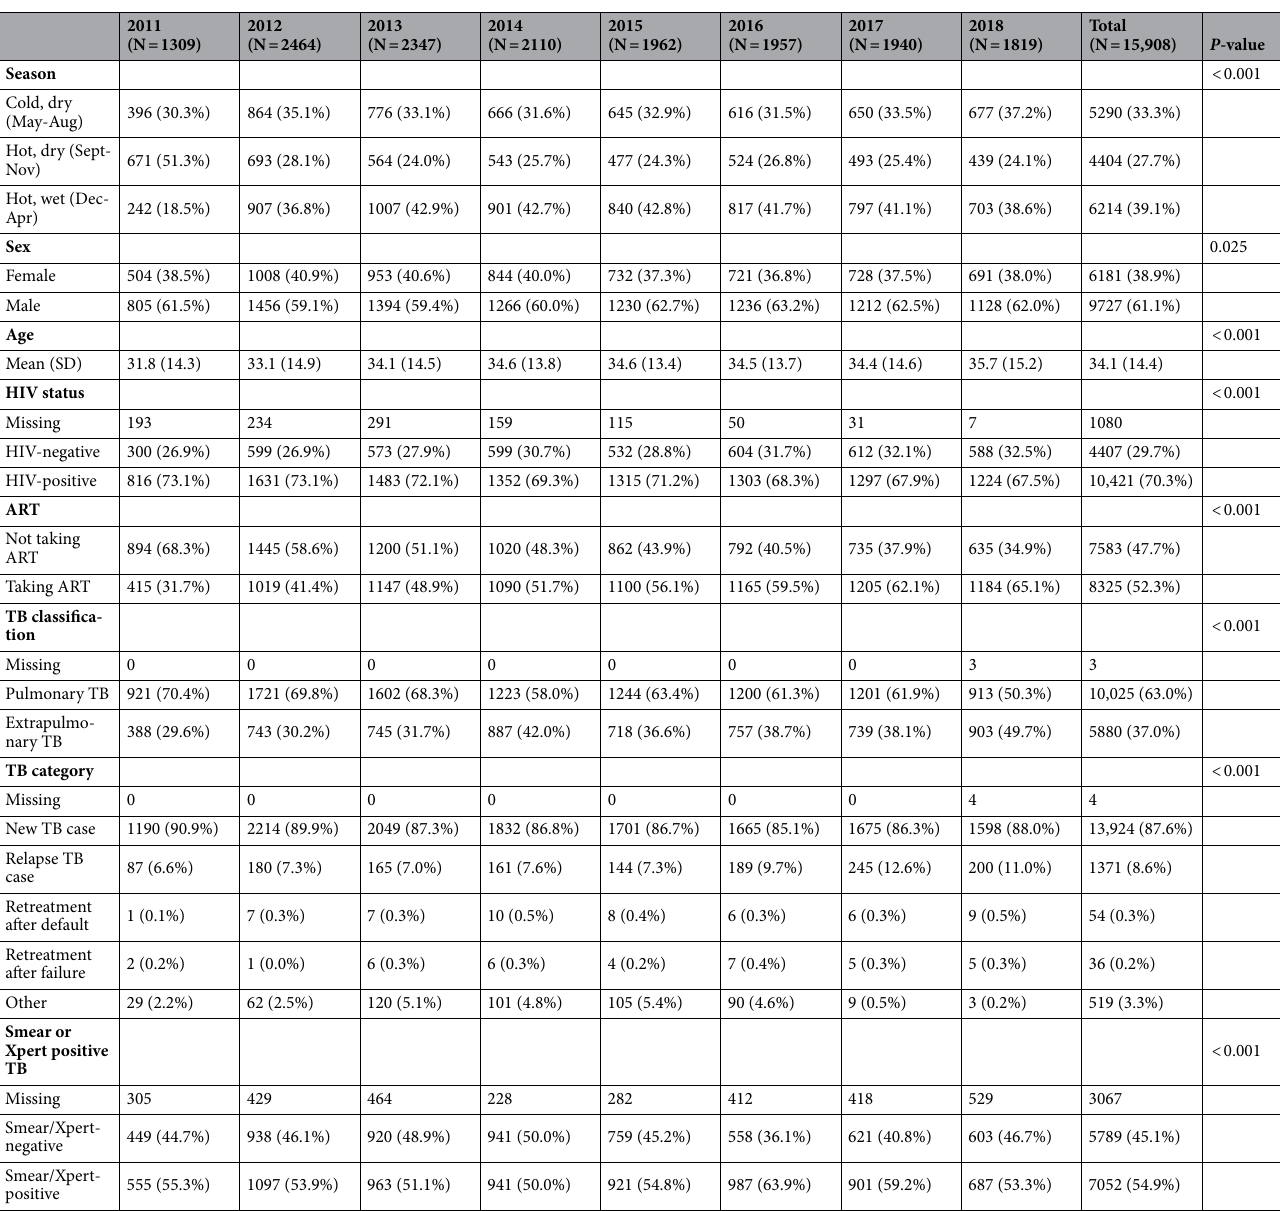
Table 1. Characteristics of Blantyre TB patients registered for treatment, April 2011 to December